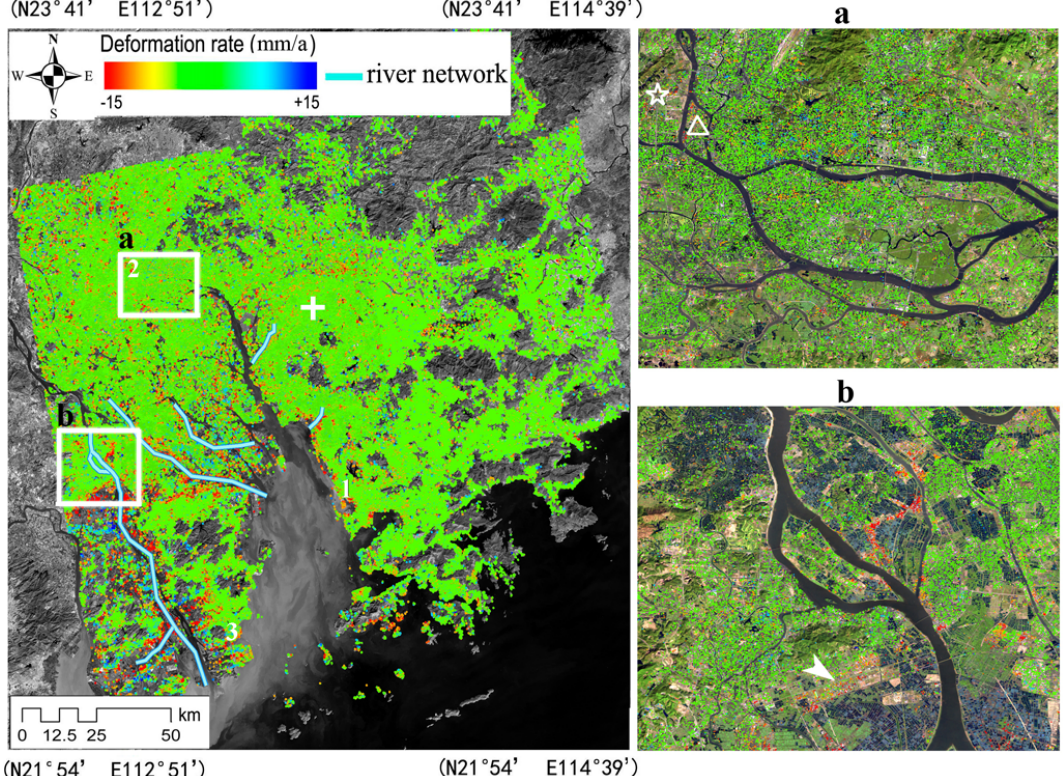
Fig. 3. Annual surface displacement rates over the GPRD (marked by red rectangles in Fig. 1) derived by Persistent Scatterer Interferometry (PSI) model, overlapped on a SPOT remote sensing image. The primary values are in the range of − 15mma − 1 to 15mma − 1 in the span of 2006 ∼ 2010, and the significant displacements are located along the river network, marked by the blue line (derived by manual using the SPOT 5 image interpretation). Two detailed displacement images (a) Guangzhou (b) Jiangmen combined with field investigations demonstrate that the settlements have close relationship with anthropogenic activities. The white cross indicates the reference point for the integrated whole velocity field; symbols of pentagram, triangle and arrow indicate the locations of ground collapse accidents in 2007–2008, ground instability by the high-speed railway track in 2010, and Jiang men new development zones built in the last 10yr, respectively. The numbers “1, 2 and 3” indicate the locations of PS time series in Fig. 5a, b and